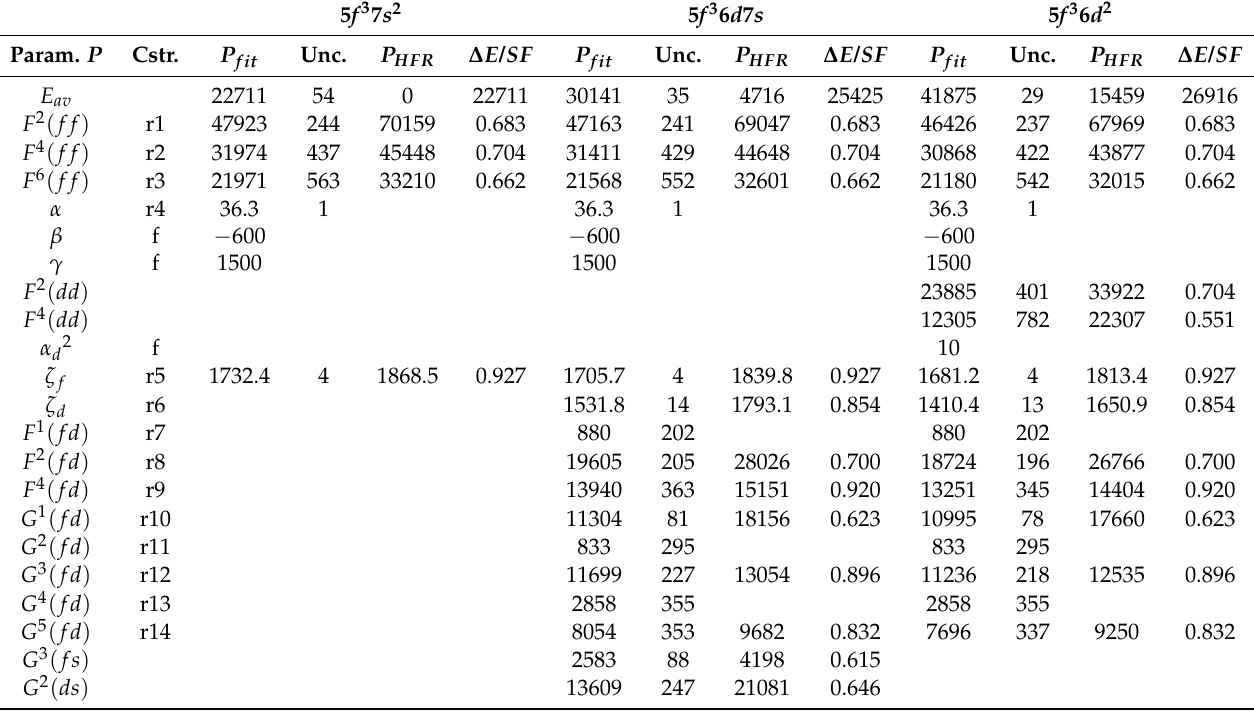
Table 2. Fitted parameters (in cm − 1 ) for odd parity configurations of U II compared with HFR radial integrals. The scaling factors SF ( P ) = P fit / P HFR (dimensionless) are replaced by ∆ E = E fit – E HFR for E av average energies (in cm − 1 ). Constraints on some parameters are in the second column under ’Cstr.’ (denoted ’f’ for fixed parameters or ’rn’ , which link parameters of the same ’rn’ to vary in a constant ratio). The HFR values of E av parameters are relative to the ground state configuration 5 f 3 7 s 2 taken as zero